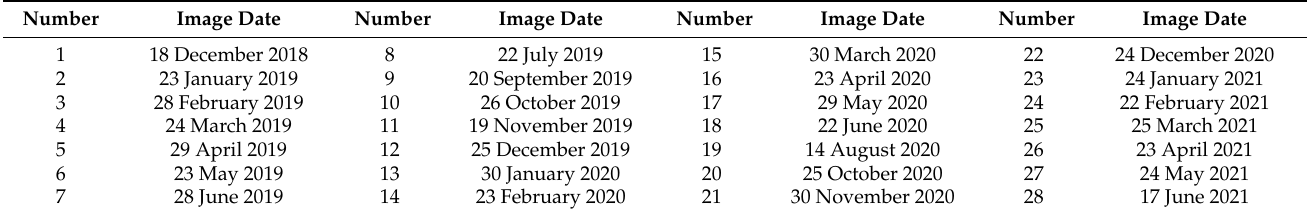
Table 1. Sentinel-1A image acquisition